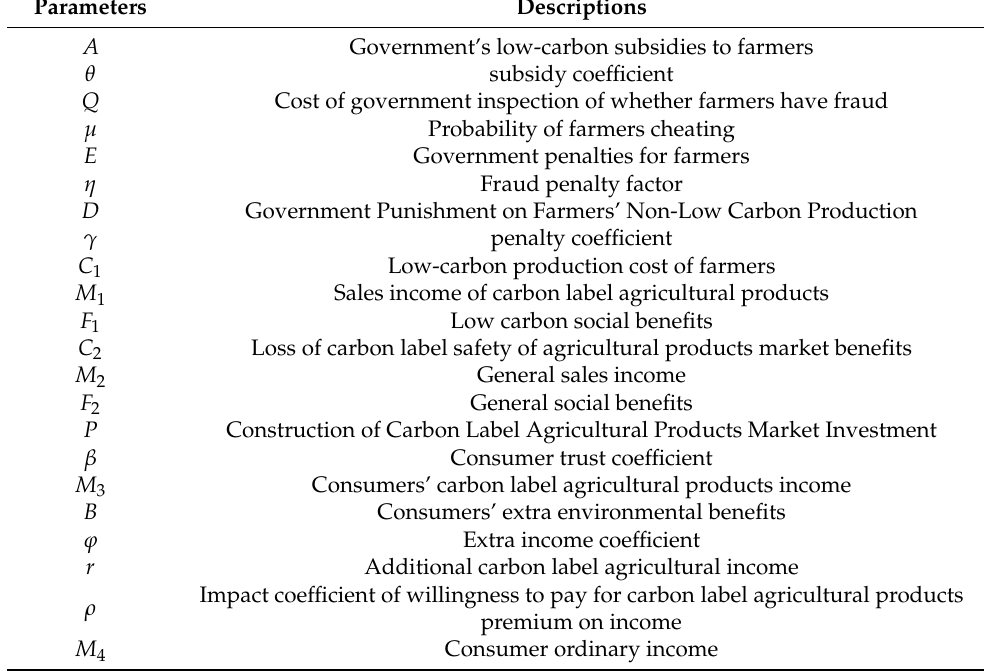
Table 1. Parameter descriptions.